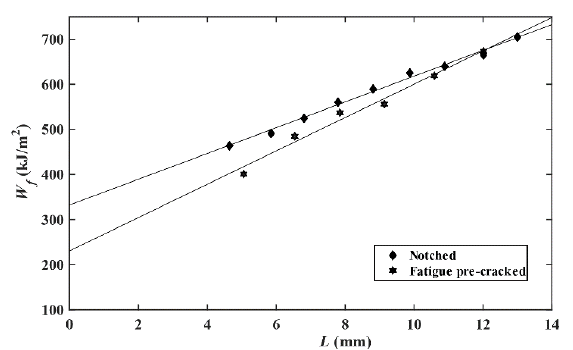
Figure 5. Maximum stress versus ligament length for all DENT specimens.